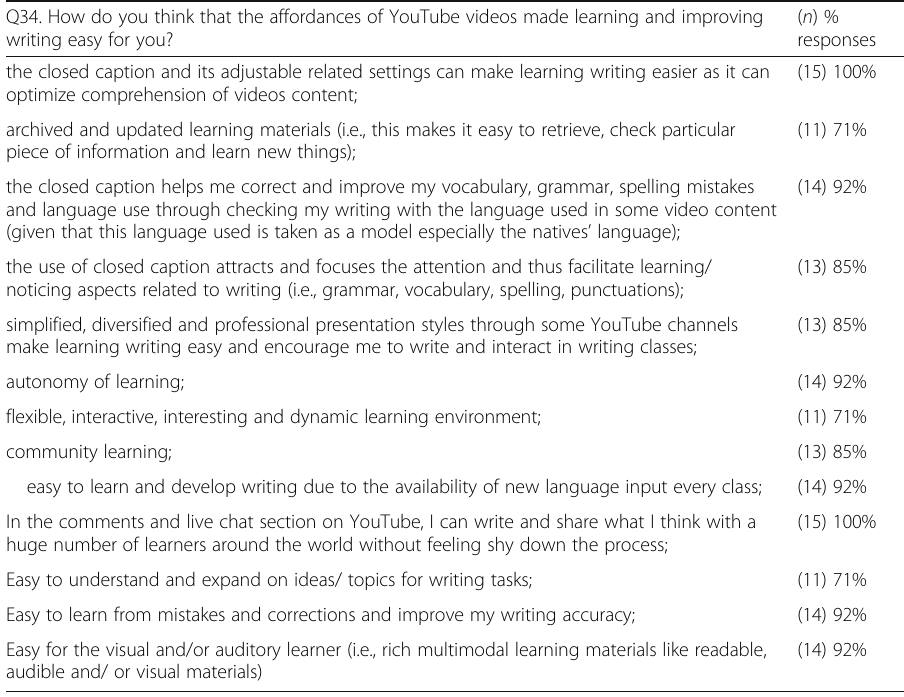
Table 9 Learners ’ perspectives on how the affordances of YouTube videos made learning and improving writing